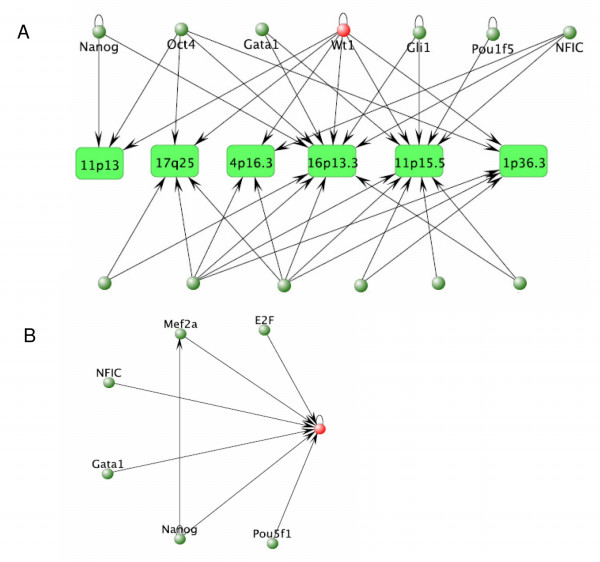
Regulatory Network at Wilms' Tumor Associated Loci. Figure 6A depicts the TFs, 13 in all, which target chromosomal loci thought to be involved in development of Wilms' tumor or which show significant enrichment of genes which are targets of WT1. Only TFs which have significant target overlap with WT1 are shown. Six of the TFs also regulate WT1 (based on our predictions). 6B shows only TFs that potentially regulate WT1, and the inferred interactions between them.